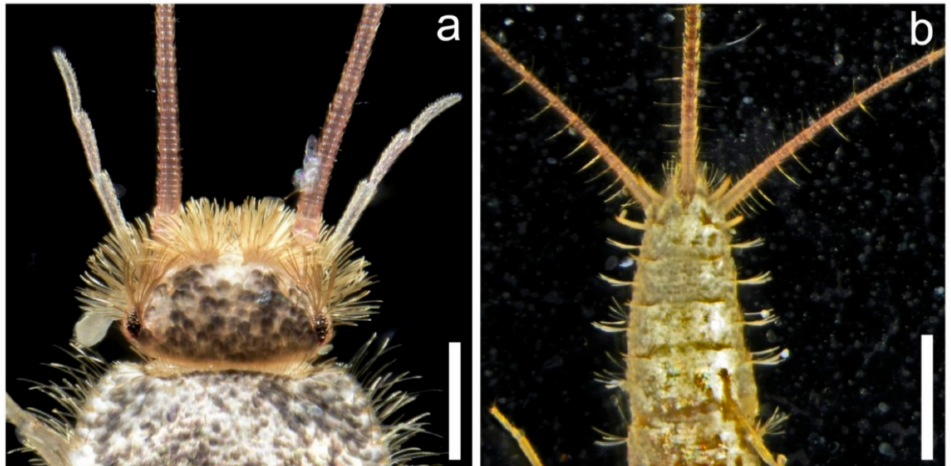
Figure 1. ( a ) Head of the captured male of Ctenolepisma longicaudatum , dorsal side; ( b ) abdomen of the captured C. longicaudatum , ventral side, (scales: ( a ) 0.1 mm; ( b ) 2